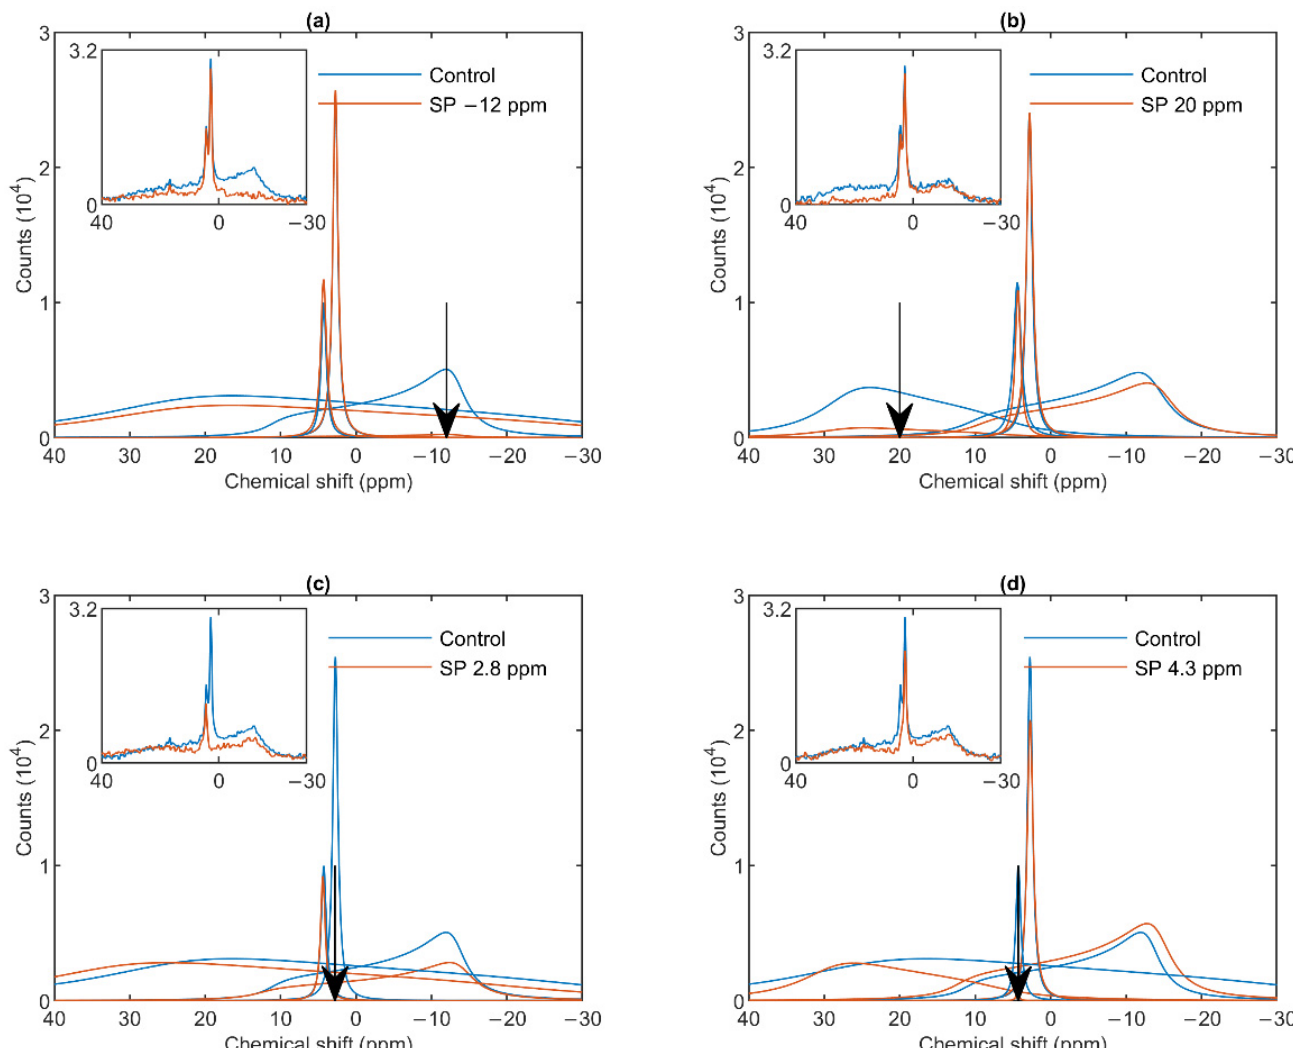
Figure 3. 31 P-NMR spectra of stroma thylakoid membranes in the absence (Control, blue curves) and presence (SP, red curves) of saturation pulses applied at different frequencies, as indicated by the arrows, at or close to the peak position of different phases: L, − 12 ppm ( a ); H II , 20 ppm ( b ); I 1 , 2.8 ppm ( c ) and I 2 , 4.3 ppm ( d ). Each panel shows the deconvoluted component spectra and, in inset, the measured spectra, averages from two independent batches with similar spectral features; temperature, 5 °C.